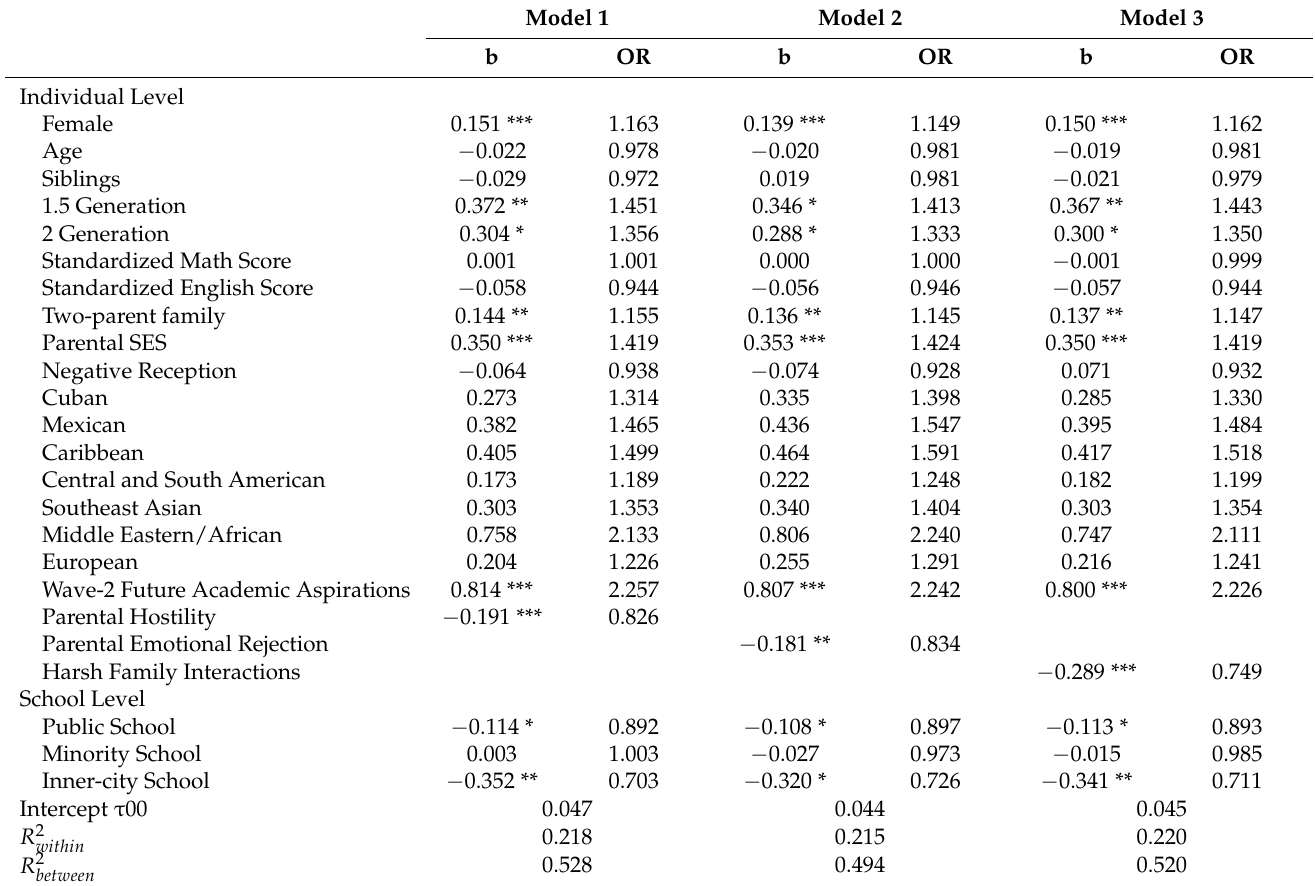
Table 4. Generalized linear mixed modeling predicting the effects of parental hostility, emotional rejection, and harsh family interactions with parents in early adolescence of immigrant youths and academic aspirations of immigrant youths in late adolescence on their successful college graduation in young